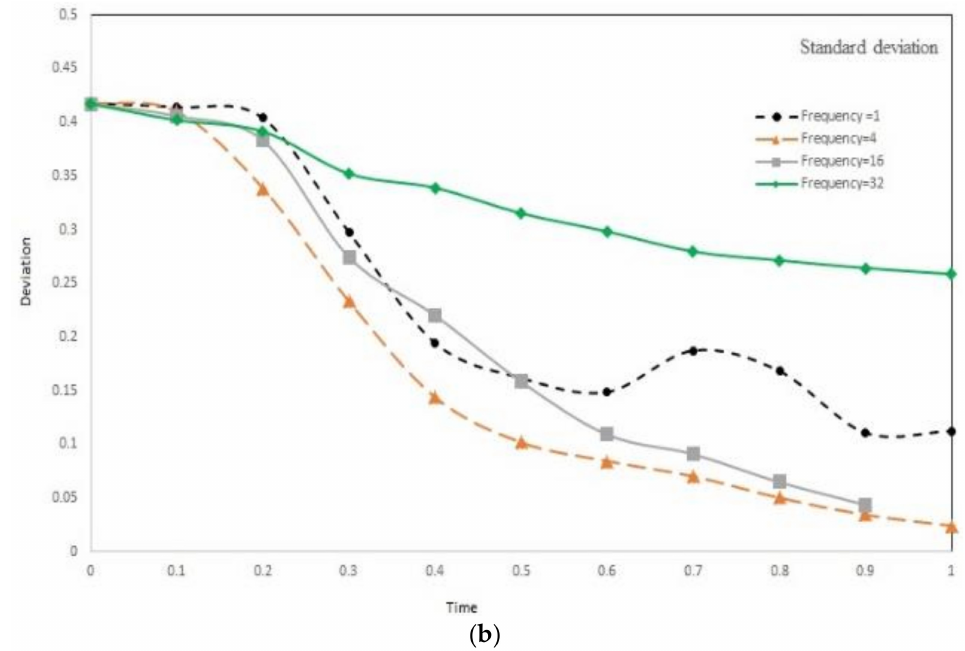
Figure 19. Assessing quality of mixing: ( a ) Deviation in pixel intensities at outlet versus time at different voltages: by increasing voltage the deviation is reduced. ( b ) Deviation in pixel intensities at outlet versus time at different frequencies: Mixing first improves as the frequency rises but above a certain frequency the performance deteriorates by further increase in